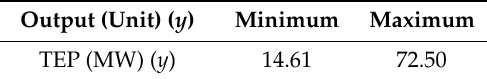
Table 2. List and notation of the